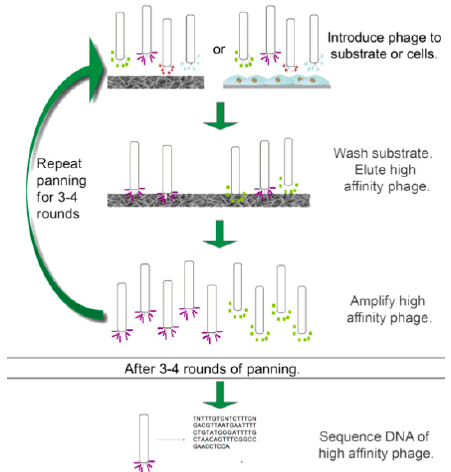
Figure 1. Schematic of panning stage of phage display. Phages are introduced to either a substrate or specific cell population followed by washing away non-adherent phages and eluting high affinity phages. High-affinity phages are amplified and the process is repeated at least 3 times to reach a consensus sequence. Image used with permission from Springer.